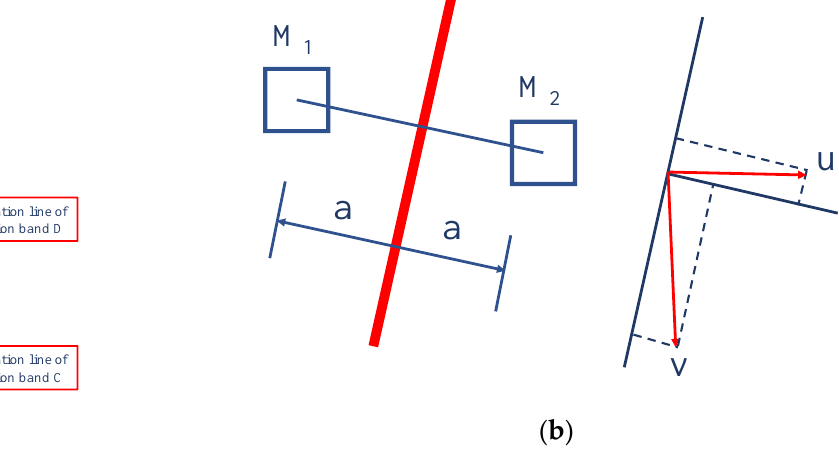
Figure 9. Analysis method of the displacement evolution of the deformation localization band [36]. ( a ) Identification and division of the deformation localization zone; ( b ) schematic diagram of displacement dislocation analysis on both sides of the deformation localization band.